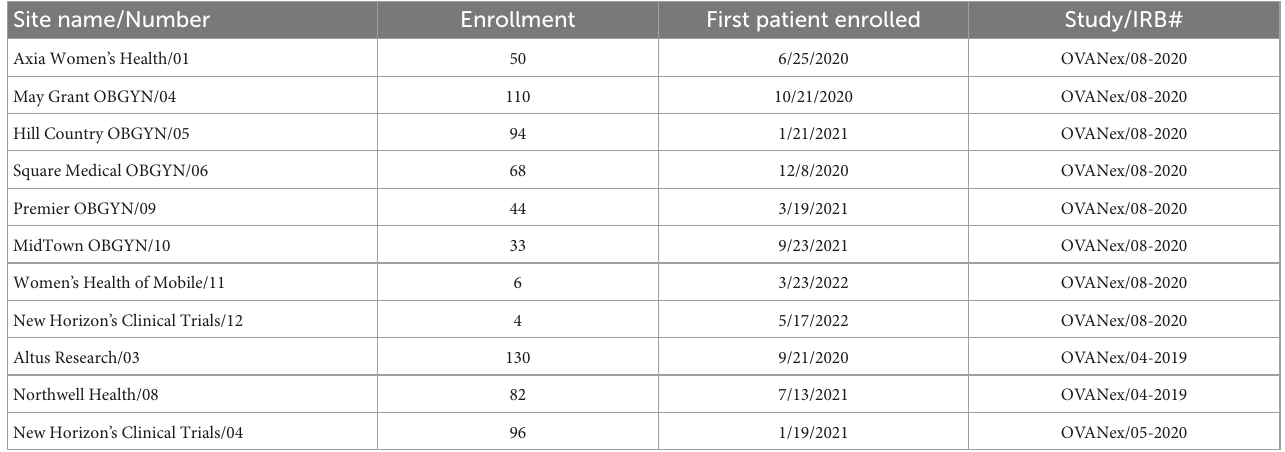
TABLE 1 Enrollment sites and internal and institutional review board (IRB) study identifiers included in the prospective